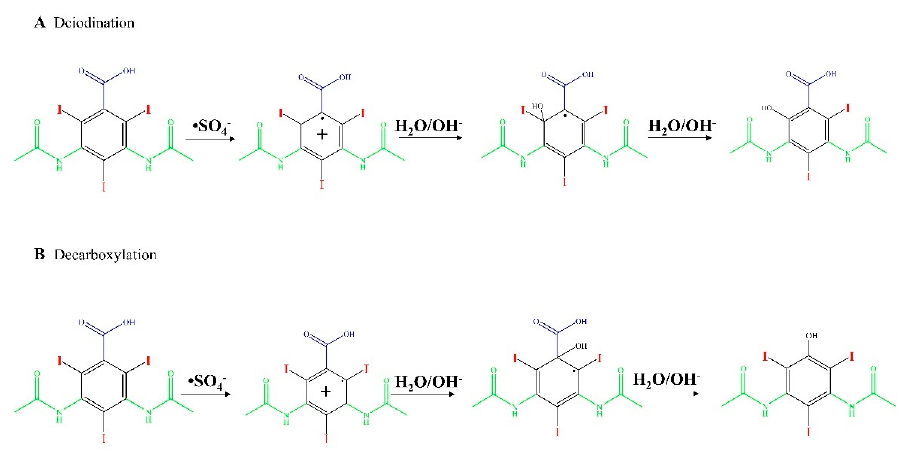
Figure 5. Proposed pathways of oxidation of diatrizoate by SO 4 • − attack [59].